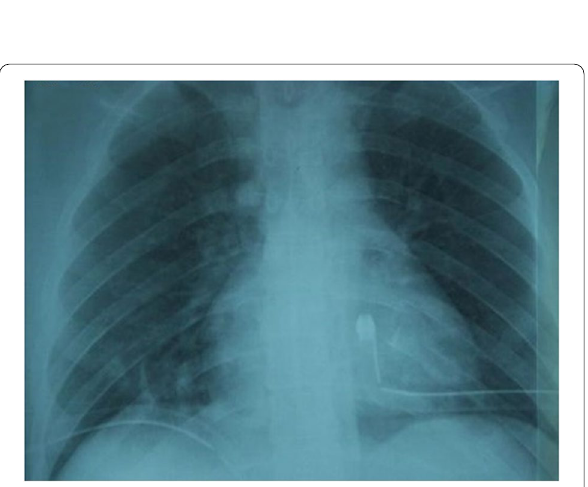
Fig. 2 Chest X-ray of case 1 shortly following admission showing fully expanded lungs, bilateral chest tubes, and normal-sized